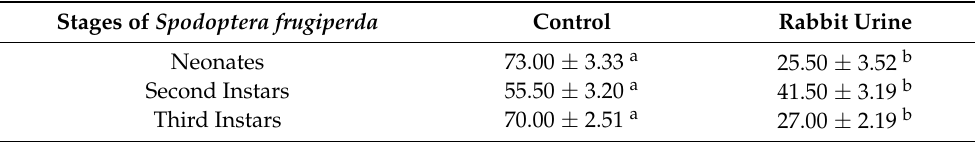
Table 1. Mean number ( ± SE) of fall armyworm larvae that remained on the maize leaves treated with rabbit urine and distilled water (control) within 24 h of exposure in the no-choice experiment. Stages of Spodoptera